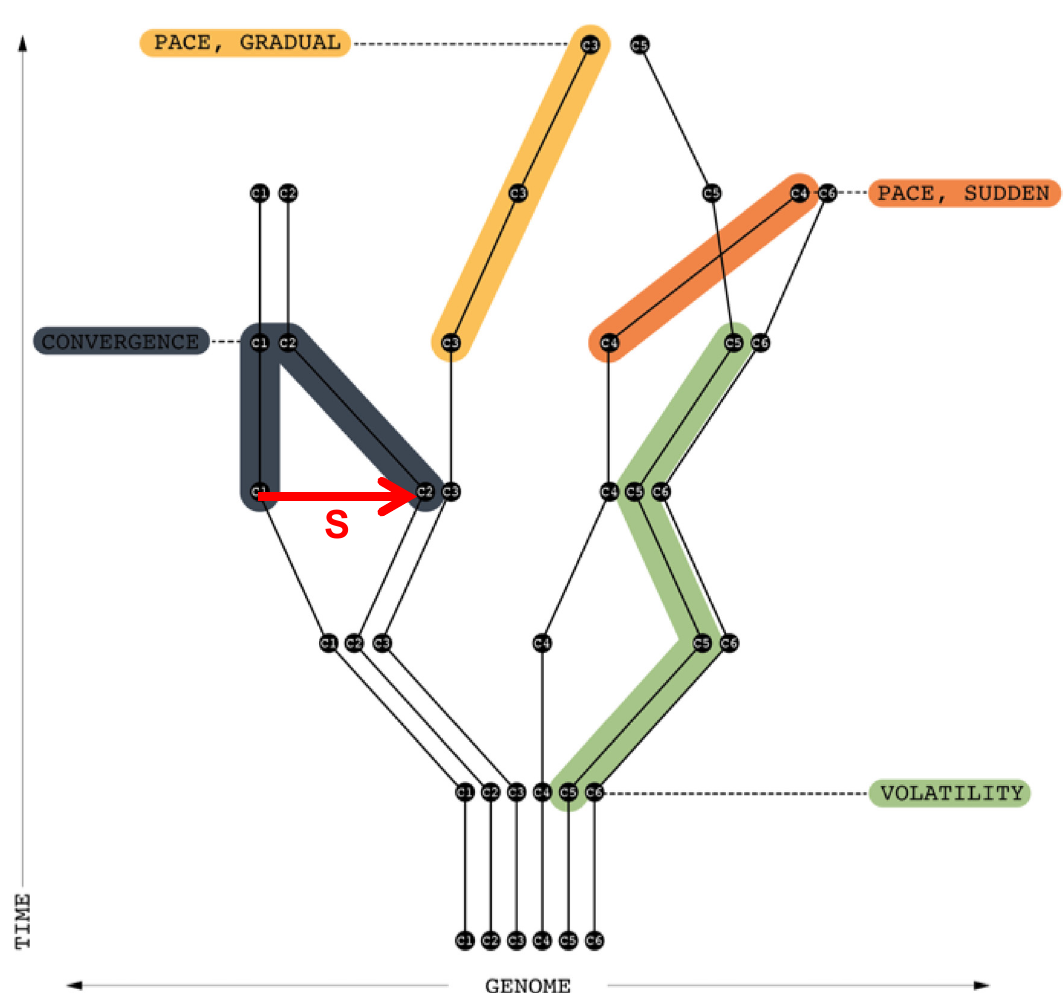
Figure 7. Signal Induced Convergence.